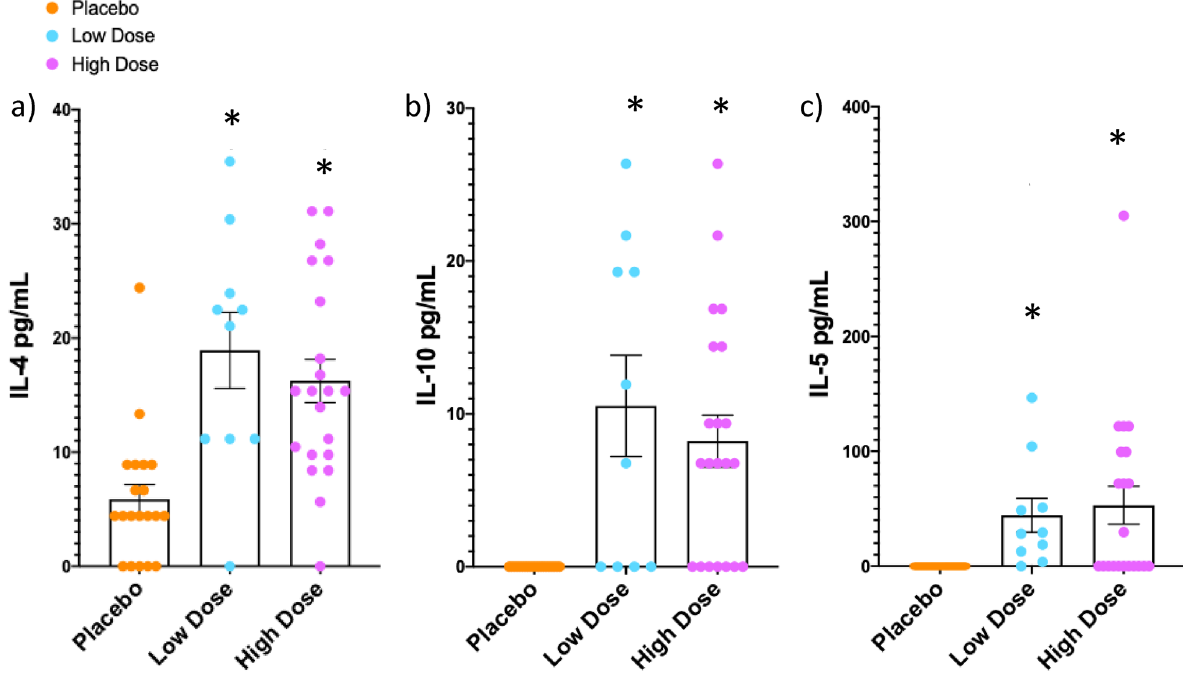
Figure 6. Probiotic intervention alters cytokines following social stress. Following repeated social defeat, circulating concentrations (pg/mL) of IL-4 ( a ), IL-10 ( b ), and IL-5 ( c ) were significantly increased in hamsters treated with both doses of the probiotic (low dose, n = 7, blue dots) (high dose, n = 20, purple dots) compared with placebo ( n = 20, orange dots) (*significantly higher than placebo, p < 0.01). Data presented as mean +/− standard error of the